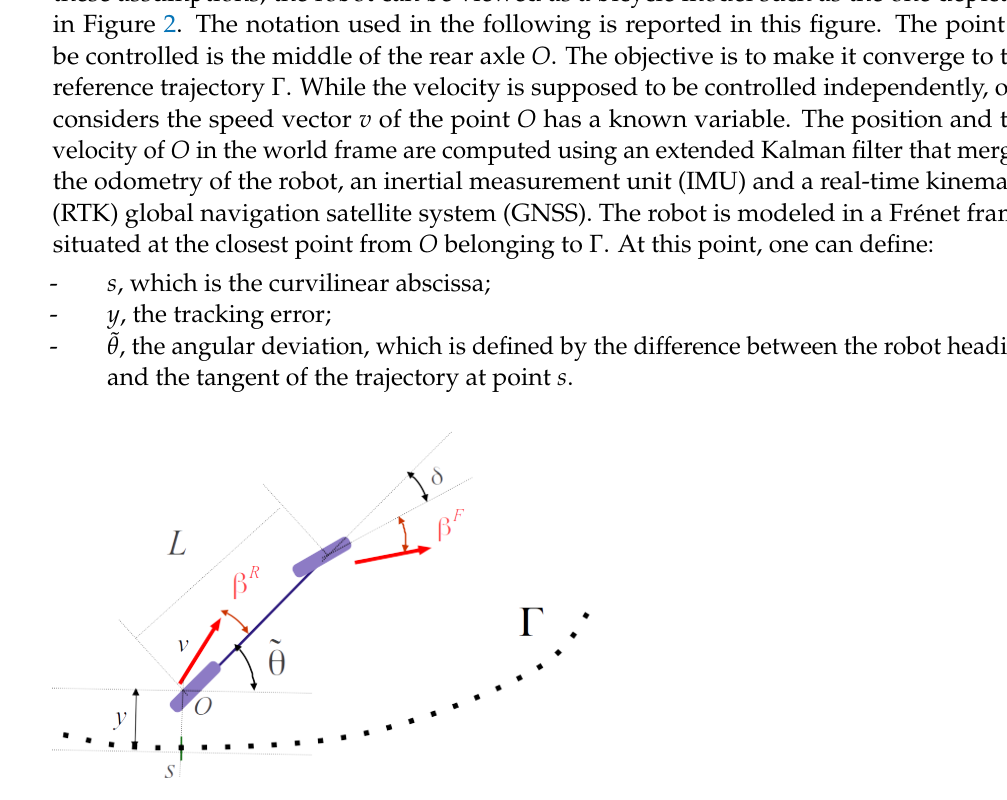
Figure 2. Extended kinemtic model of the robot for path following